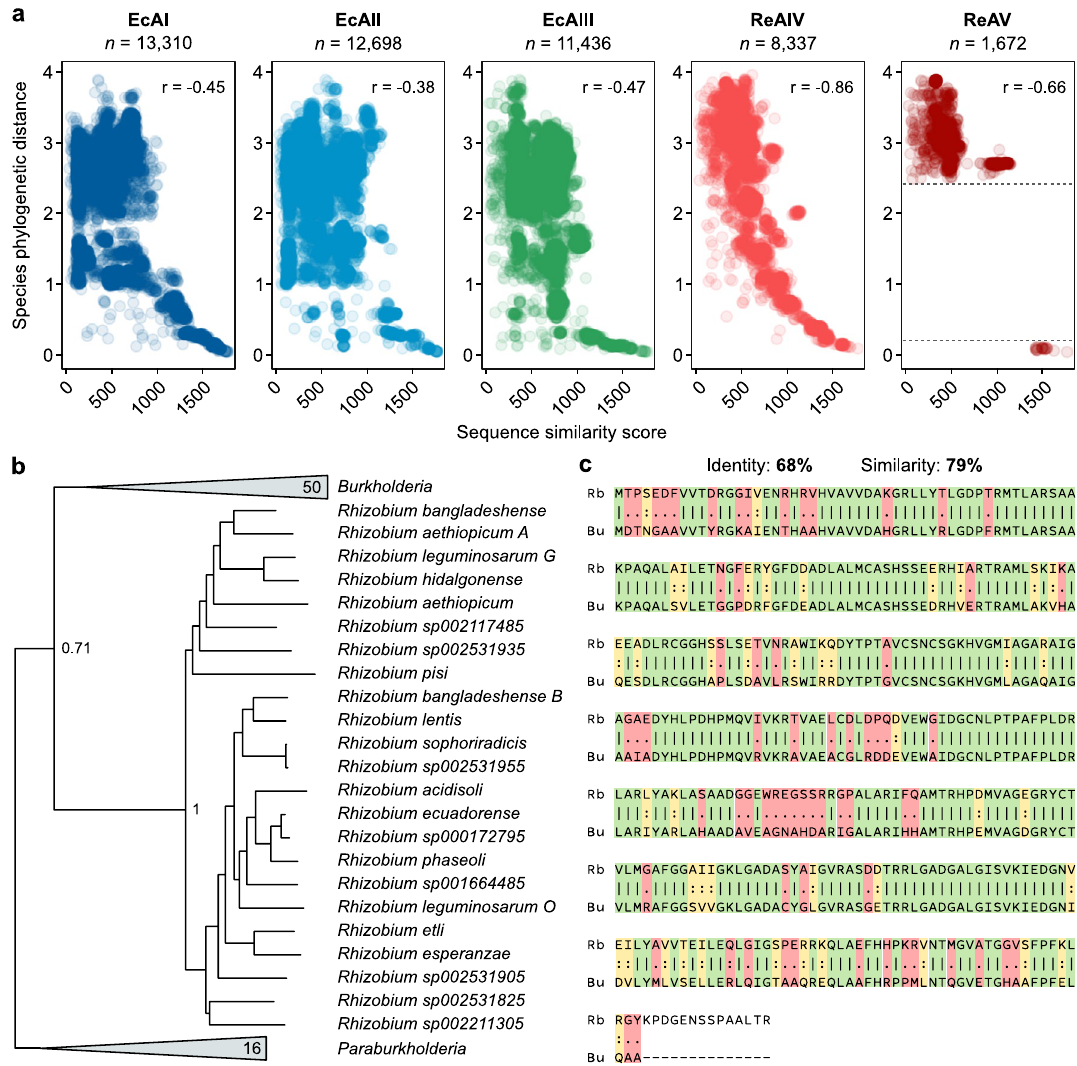
Figure 2. Relation between sequence similarity of l-asparaginase proteins and phylogenetic distance between species. (a) Alignment score of orthologous l-asparaginases and phylogenetic distance separating the bacterial species. Protein sequence of each prototypic enzyme (EcAI, EcAII, EcAIII, ReAIV, and ReAV) was separately aligned to all its orthologous sequences from other bacterial species. The phylogenetic distance between bacterial species was obtained from the GTDB reference tree of bacteria. Each dot in the scatterplots represents a single comparison between a prototypic enzyme protein and an orthologous sequence from other bacterial species. ( b) Fragment of the phylogenetic tree of AV proteins in bacterial species ( n = 1672) showing close evolutionary relation of AV proteins between the species of Rhizobium ( n = 23) and Burkholderia ( n = 50). Bootstrap support values are shown on the main tree branching. ( c ) Global sequence alignment of AV proteins from Rhizobium bangladeshe (Rb) and Burkholderia ubonensis (Bu), with sequence identities (green), similarities (yellow), and differences (red) highlighted